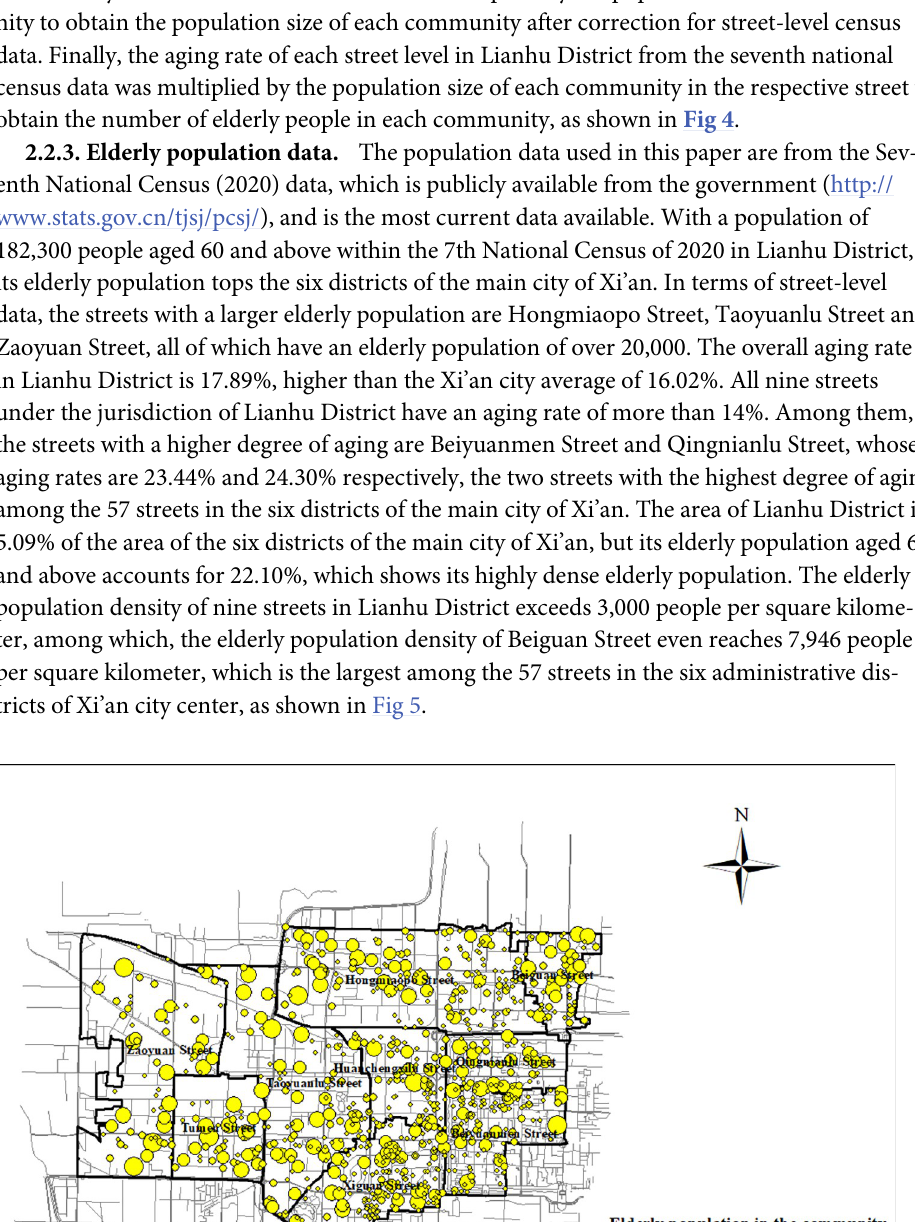
PLOS ONE | https://doi.org/10.1371/journal.pone.0277310 December14,